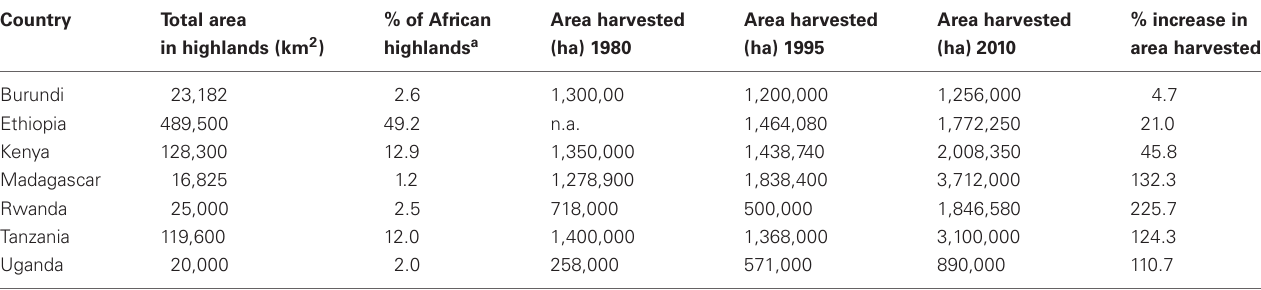
Table 3 | Increase in harvested area of maize in East Africa.